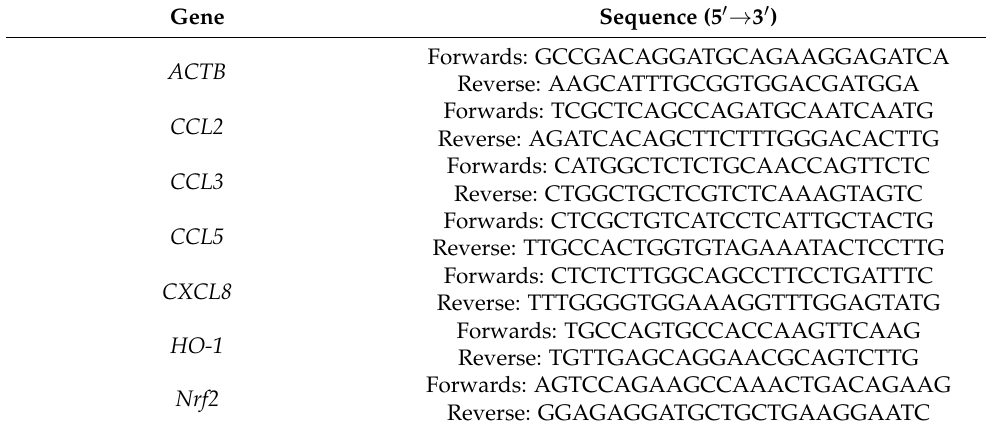
Table 3. Gene primers for